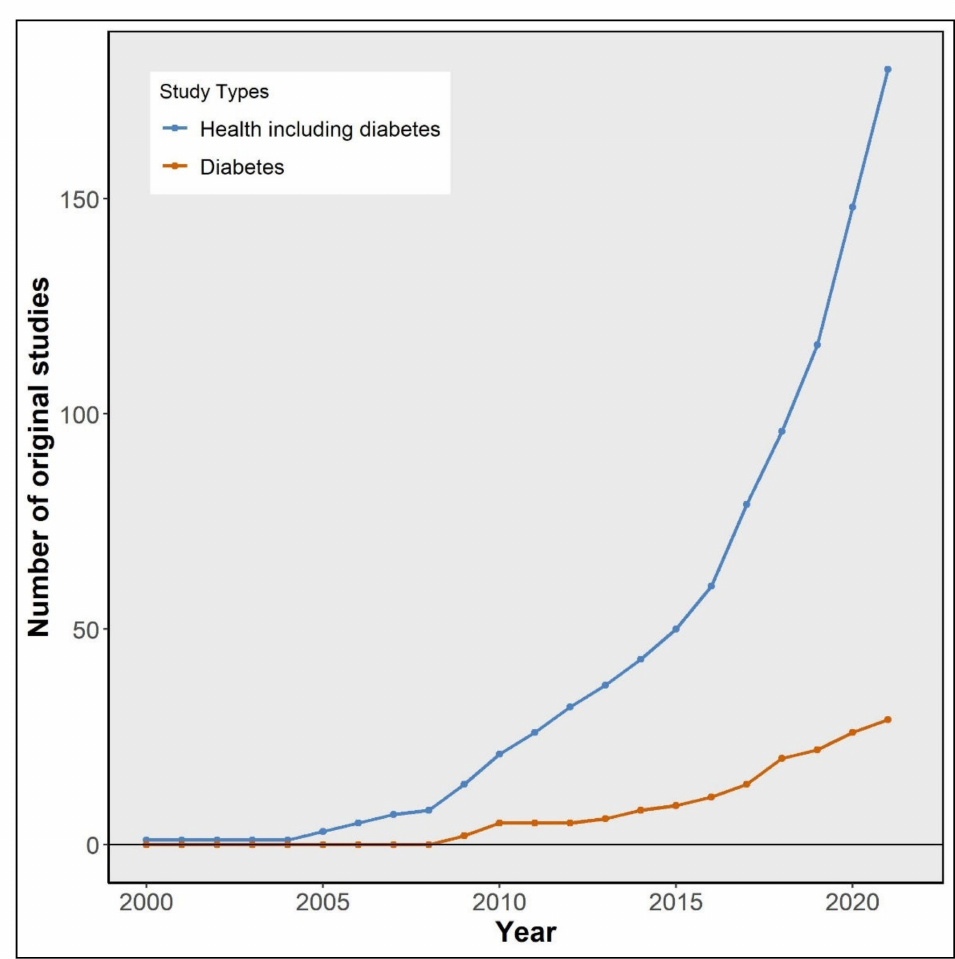
Figure 1. The cumulative number of original research articles on the Chinese famine and disease outcomes by year. The original research articles on the Chinese famine and disease outcomes included in this figure were identified using a similar search strategy as described in the methods